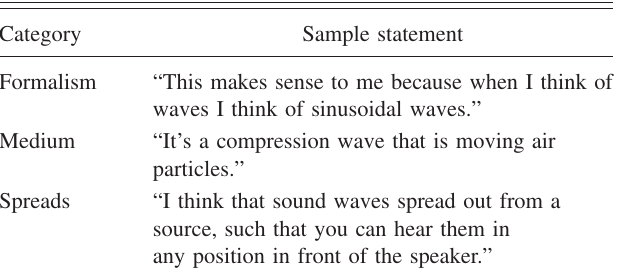
TABLE III. Long answer coding for sound.